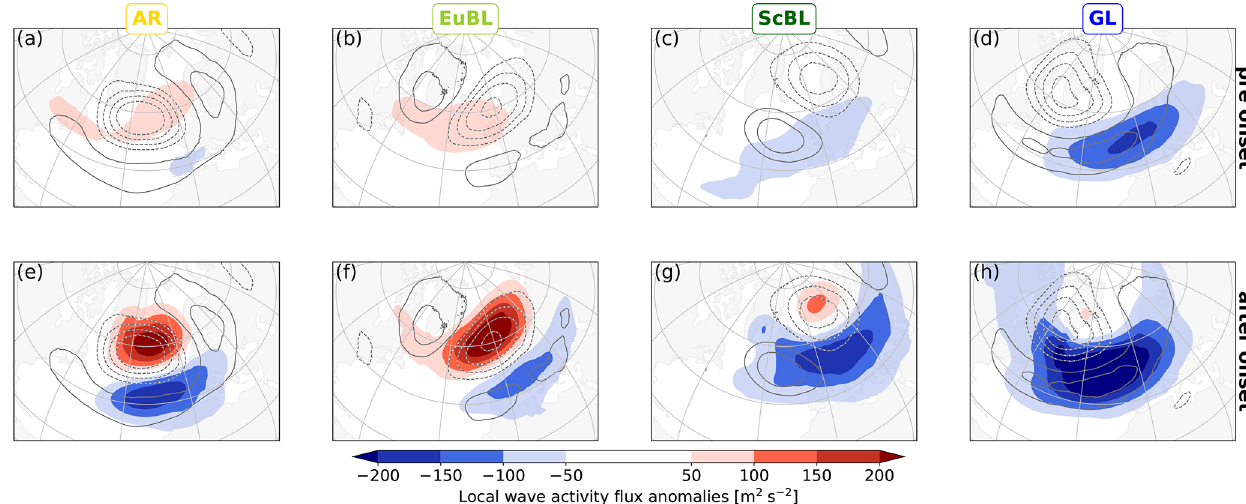
Figure 4. Same as Fig. 3 but for low-frequency anomalies of the zonal local finite-amplitude wave activity flux F λ